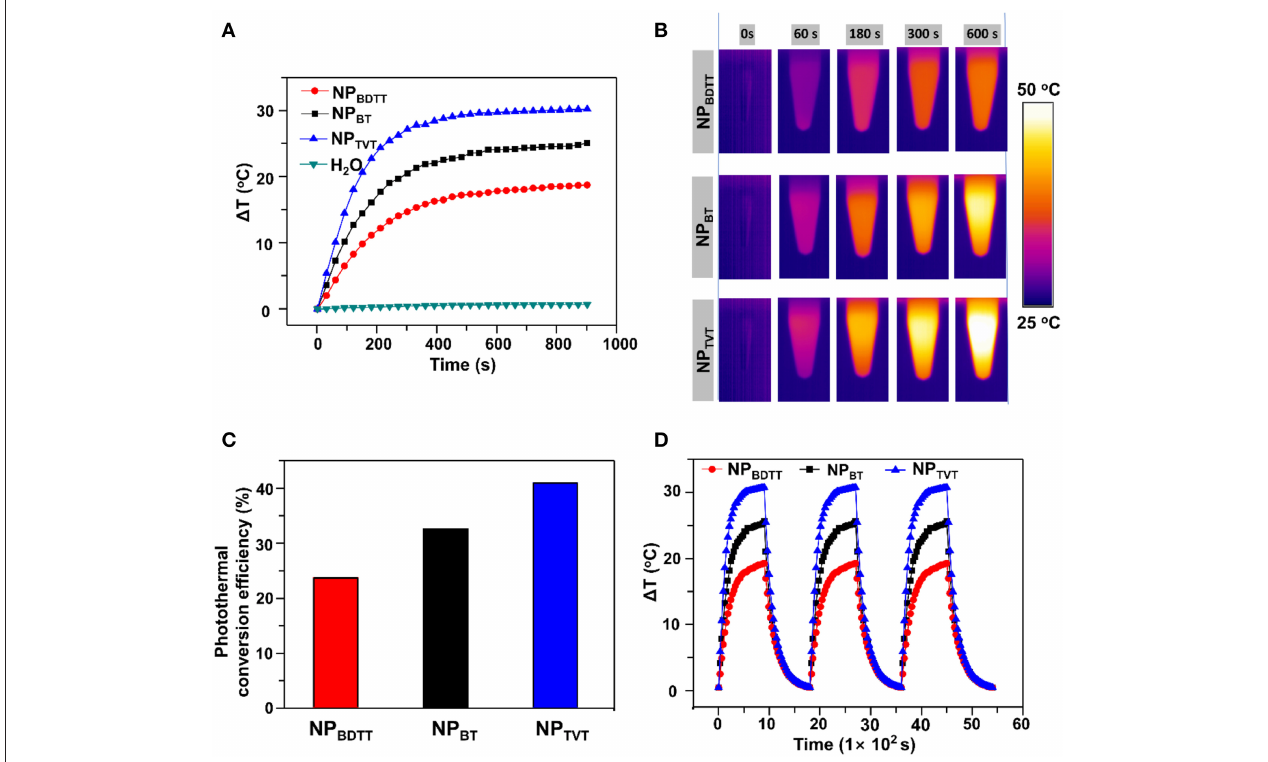
FIGURE 4 | (A) Temperature change curves of the nanoparticles upon exposure to NIR laser (808nm, 2.0 W/cm 2 , 15min). (B) Thermal images of NPs upon exposure to the NIR laser (808nm, 2.0 W/cm 2 ). (C) Photothermal conversion efficiency. (D) Temperature elevation of NPs (40.0 µ g/mL) over three laser on/off cycles of NIR irradiation (808nm, 2.0 W/cm 2 , 15min).